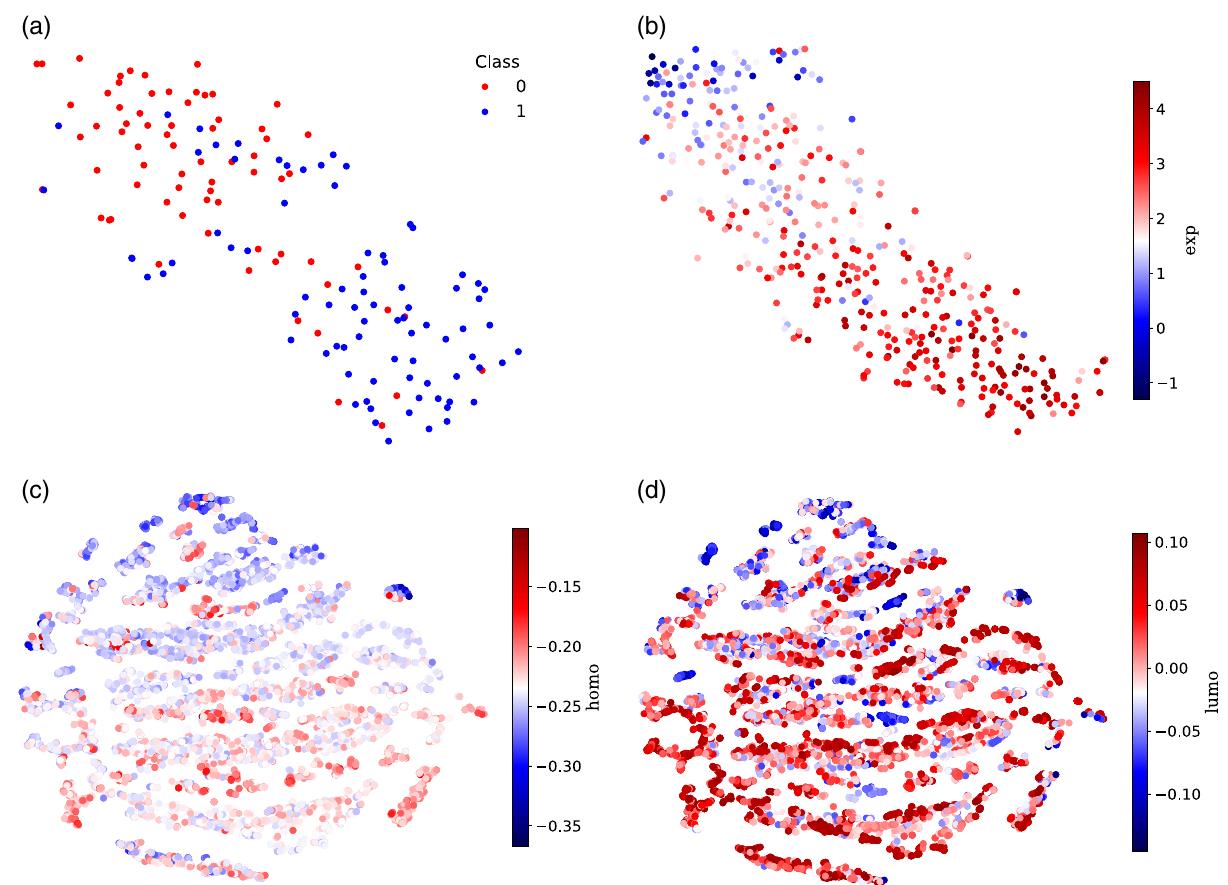
Fig. 2 Visualization of molecular representations obtained by our HiMol on the downstream test set. a BACE (Class): color represents binary labels of binding results for BACE-1 inhibitors. b Lipophilicity (exp): color represents octanol/water distribution coef fi cient. c QM9 (homo): color represents highest occupied molecular orbital energy (homo) of molecules. d QM9 (lumo): color represents lowest unoccupied molecular orbital energy (lumo) of